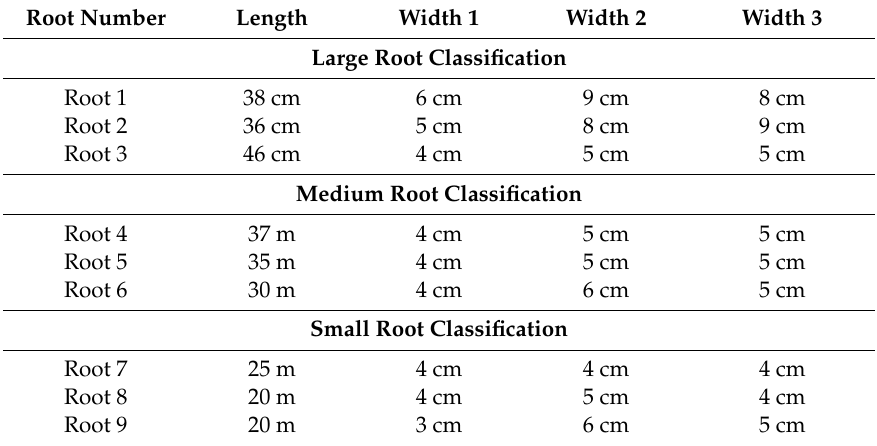
Figure 3. Illustration of root measurement procedure: ( a ) Root Length; ( b ) Root Width 1; ( c ) Root Width 2; ( d ) Root Width 3. Table 1. Dimensions of all roots utilized in the study. Measurements were derived by taking the full root length and segmenting into three sections; each section diameter was then measured to obtain width value.